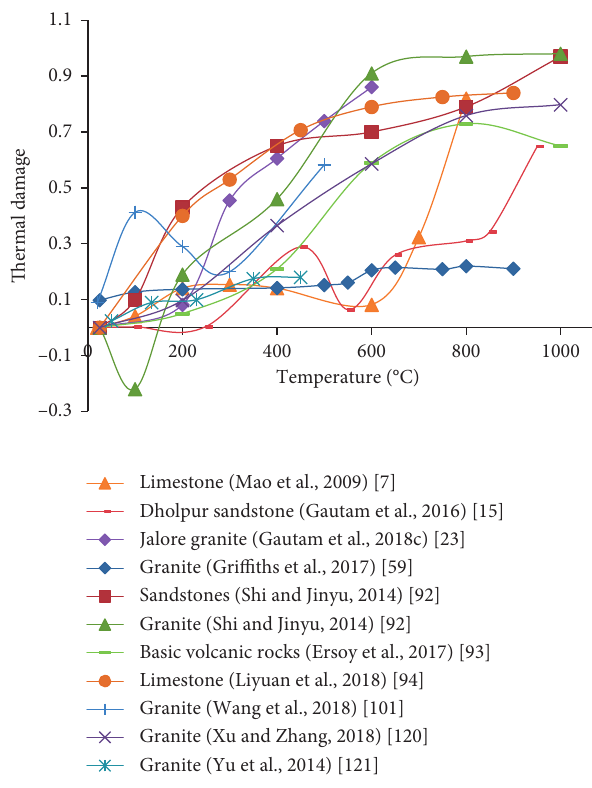
Figure 10: Evolution of thermal damage of certain